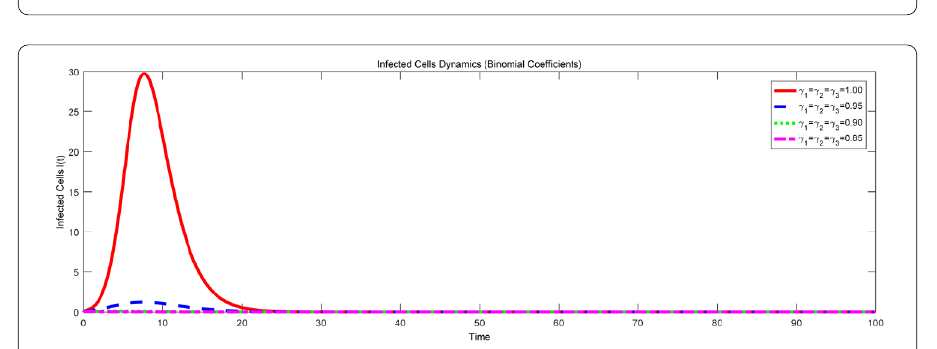
Figure 14 Dynamics of S ( t ) with γ i = 1 (solid red line), γ i = 0.95 (dashed blue line), γ i = 0.9 (dotted green line) and γ i = 0.85 (dotted dashed magenta line), i = 1,2,3.